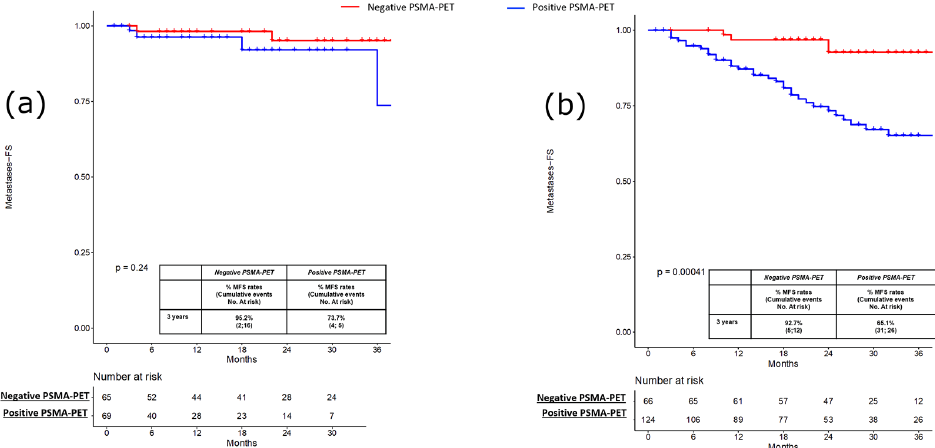
Figure 2. ( a ) Kaplan-Meier curve depicting Metastases Free Survival (MFS) rates in the pre-salvage setting ( n = 134) according to PSMA-PET results (namely, positive vs. negative); ( b ) Kaplan-Meier curve depicting Metastases Free Survival (MFS) rates in the post-salvage setting ( n = 190) according to PSMA-PET results (namely, positive vs. negative).